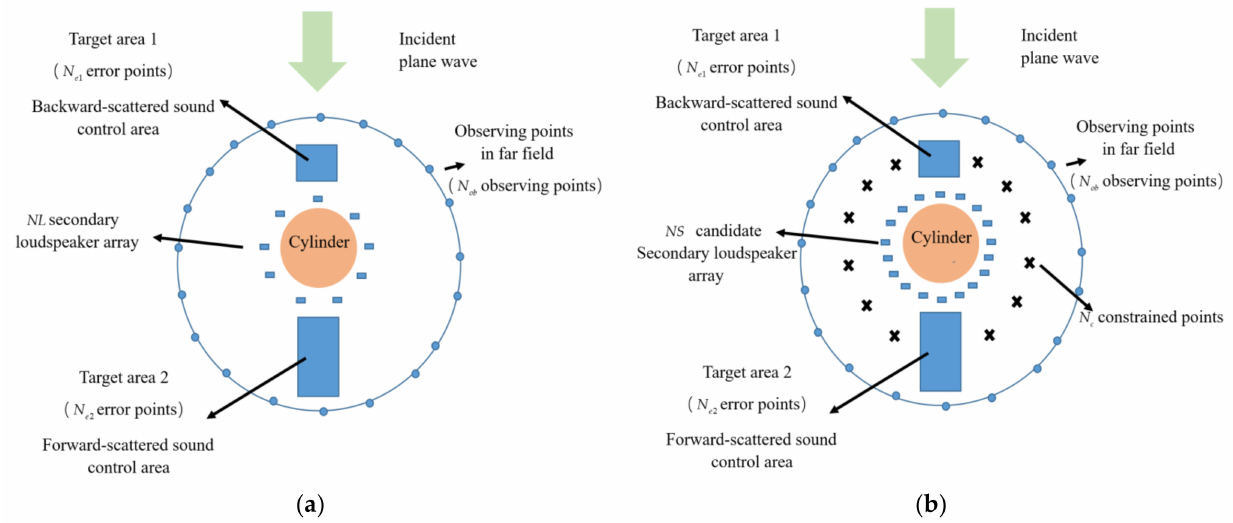
Figure 1. Schematic of: ( a ) the RLS algorithm with the uniformly placed secondary loudspeakers; and ( b ) the new algorithm. The black crosses denote the constraint